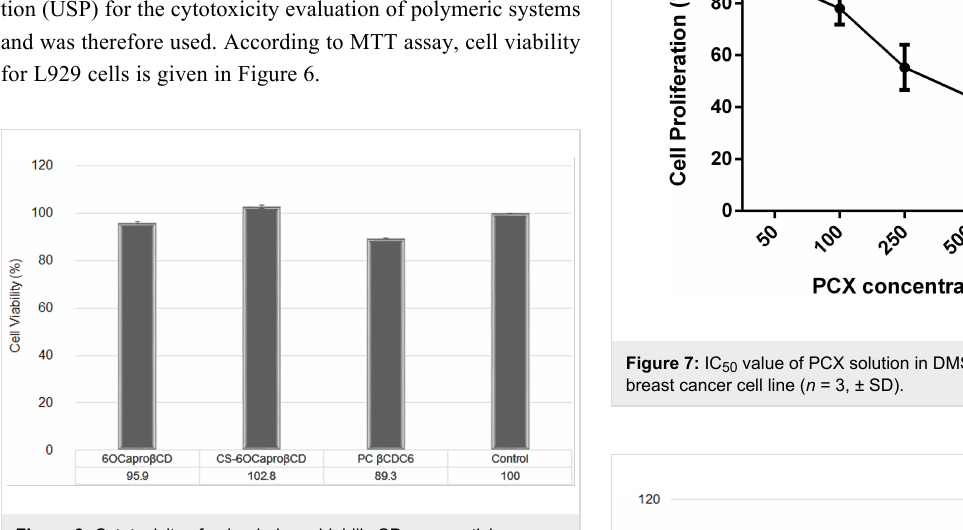
Figure 6: Cytotoxicity of unloaded amphiphilic CD nanoparticles on L929 mouse fibroblast cell line with MTT assay (CD concentration is 0.5 mg/mL in all formulation) ( n = 3, ± SD).